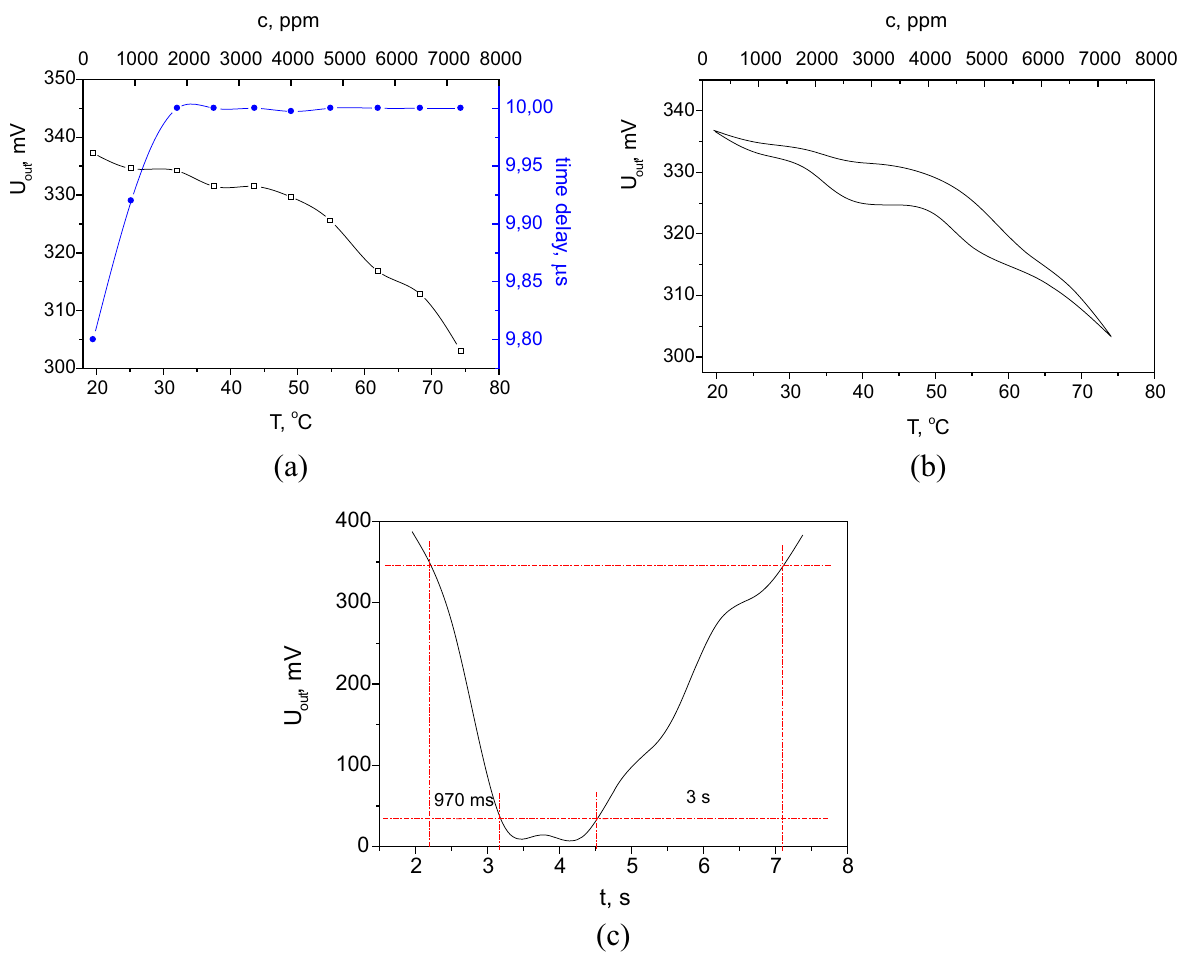
Figure 4: SAW sensor response to ethanol: ( a ) output voltage and time delay between the output and input voltage of IDTs, ( b ) hysteresis, and ( c ) response and recovery times for the textured PEDOT:PSS